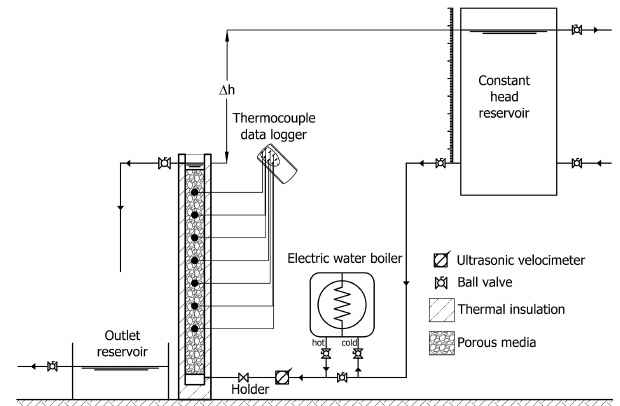
Figure 1. Setup of experimental apparatus.